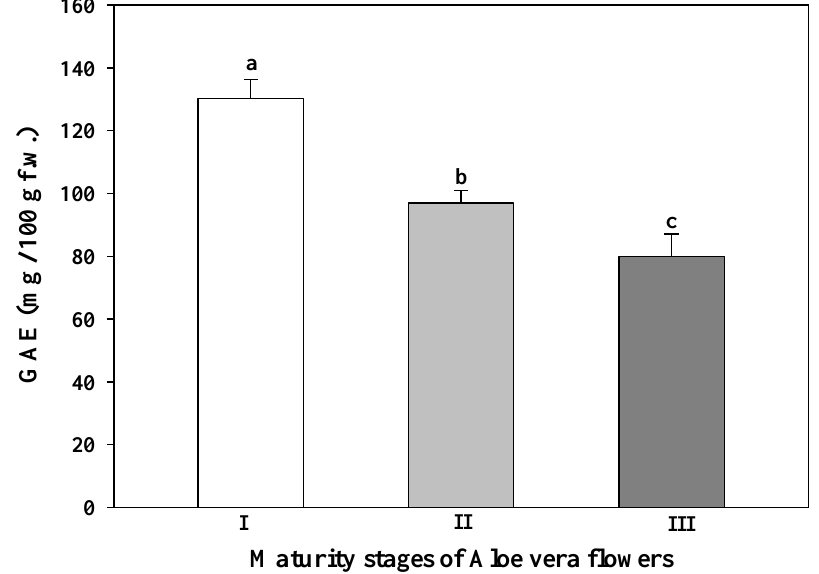
Figure 5. Total phenolic compounds of different stages of maturity of Aloe vera flowers. Stage I: immature; stage II: mature; stage III: mature, with flowers buds opened (mean ± SD, n = 3). a–c Different letters show significant differences ( p < 0.05) among the maturity stages.